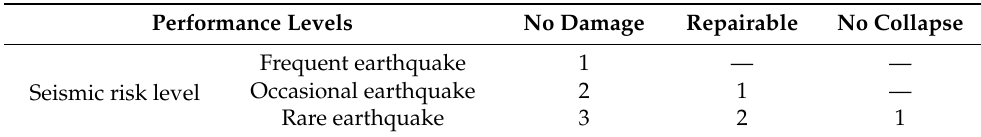
Table 1. Structural seismic objective performance in China’s seismic